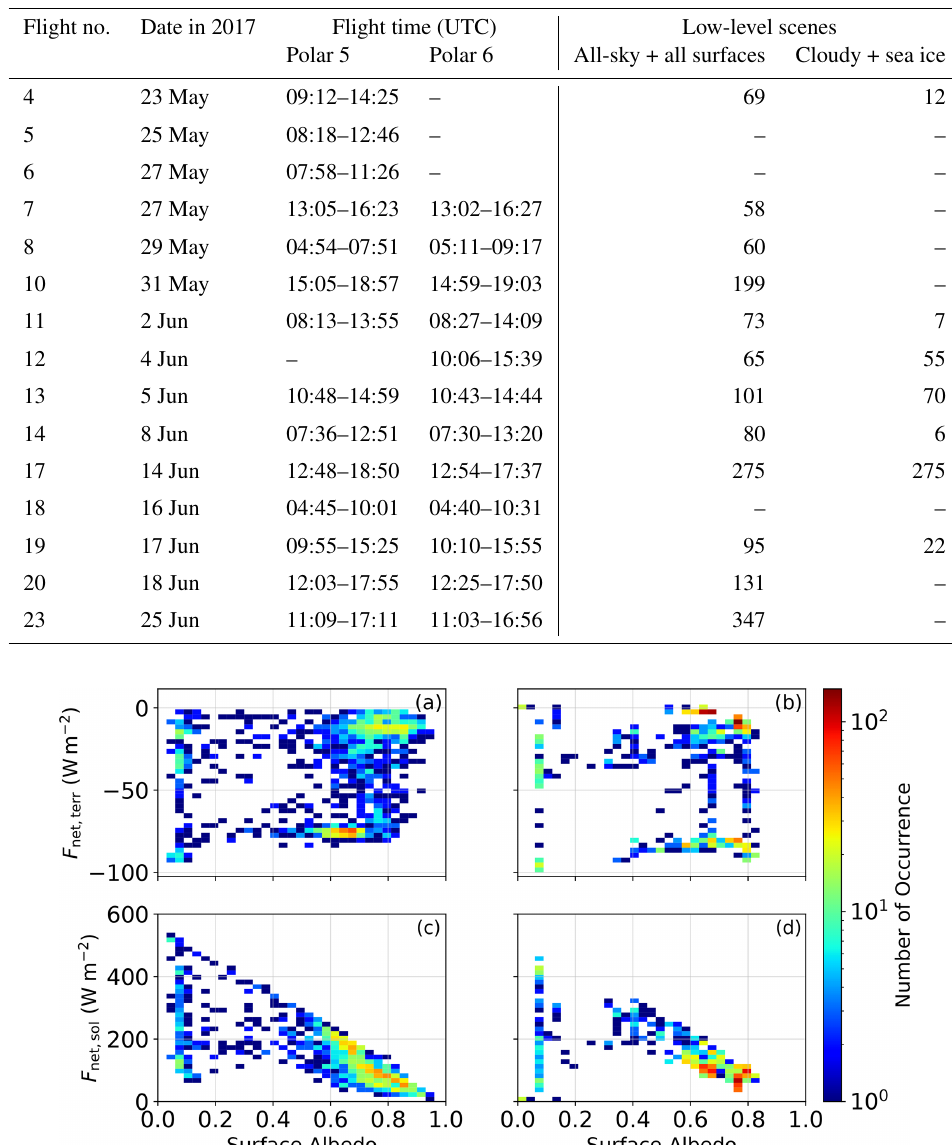
Table 1. Flights used for the comparison to ICON simulations (approximately 116 flight hours). The values given for the low-level scenes corresponds to the number of the averaged 20s intervals used in the following comparison. For more information on the scientific target of each research flight, refer to Wendisch et al. (2019) and Ehrlich et al. (2019). Flight no.